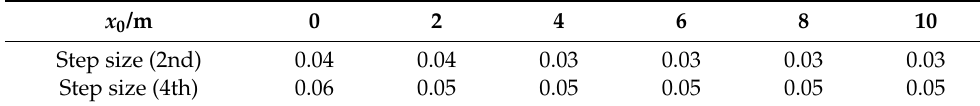
Table 3. Local optimal step size at different survey line positions.